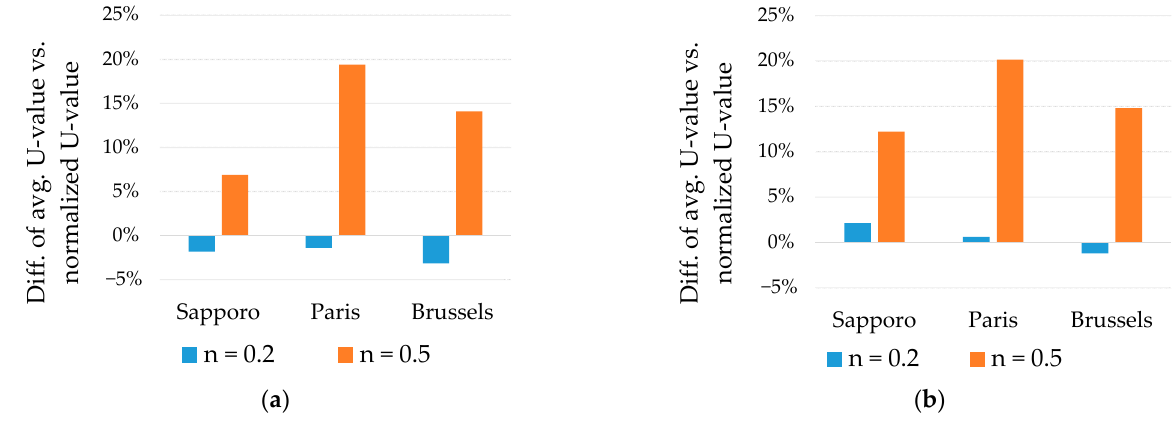
Figure 8. Accuracy of the normalization calculated as the difference of average U-value vs. normalized U-value ( a ) single floor model, ( b ) whole building model.